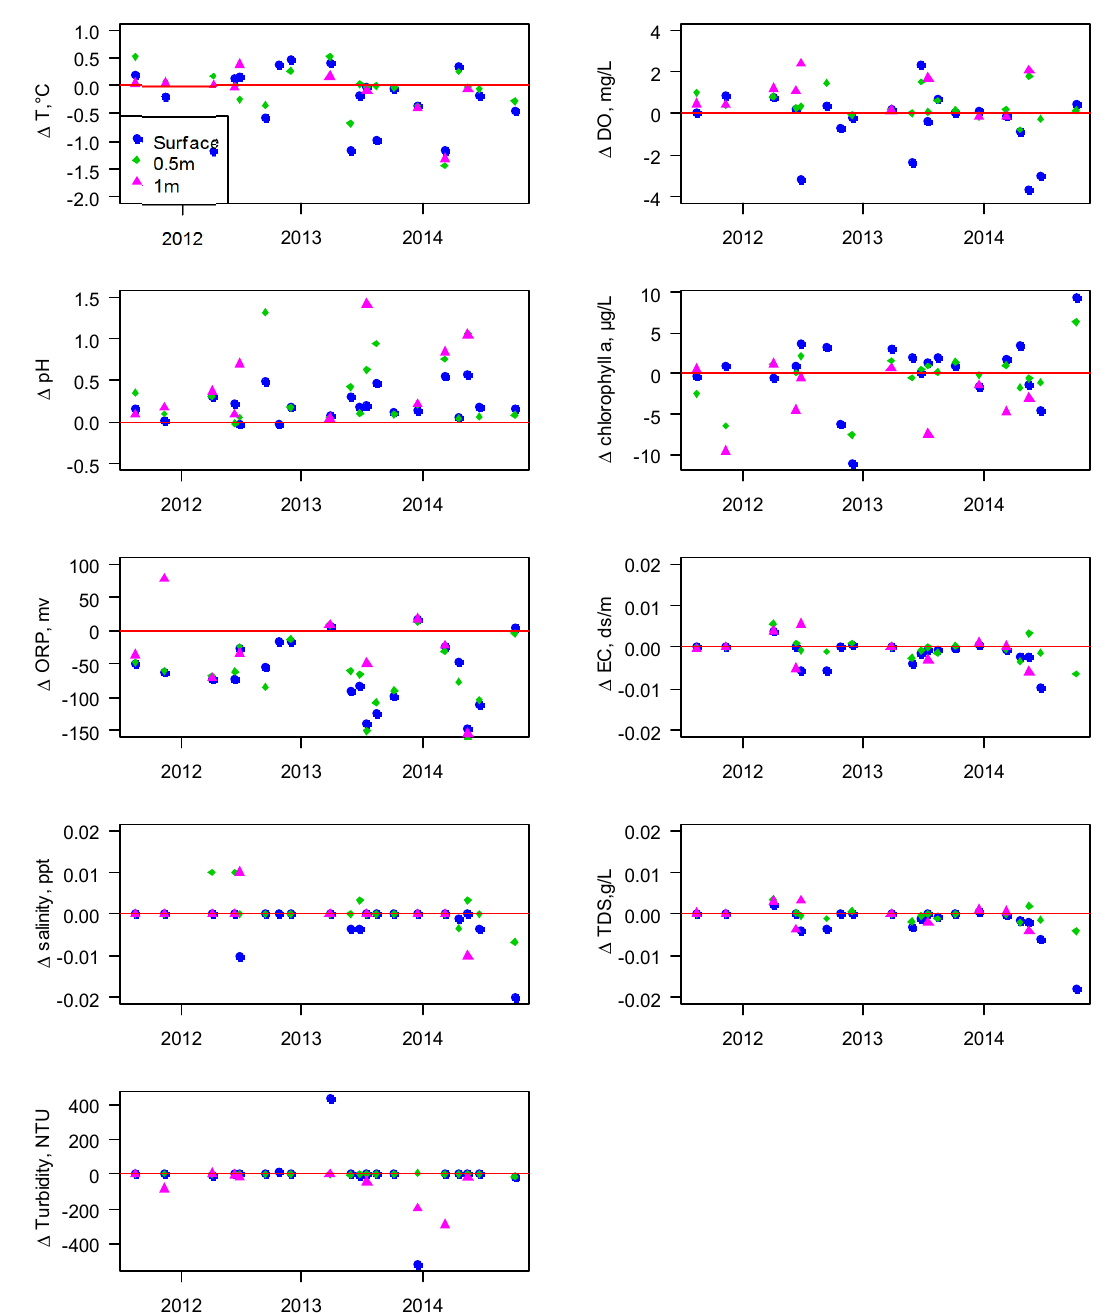
Figure 4. Water quality differences between the middle and the entrance at various water depths in reservoir VA21 during the 2011 to 2014 sampling period. The highlighted area marks the stratification